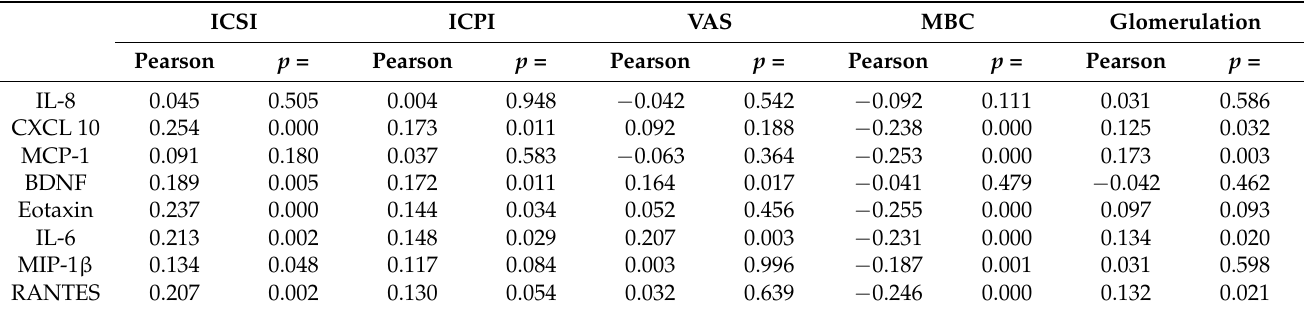
Table 3. Correlation coefficient between urinary biomarkers and bladder conditions in overall patients with interstitial cystitis/bladder pain